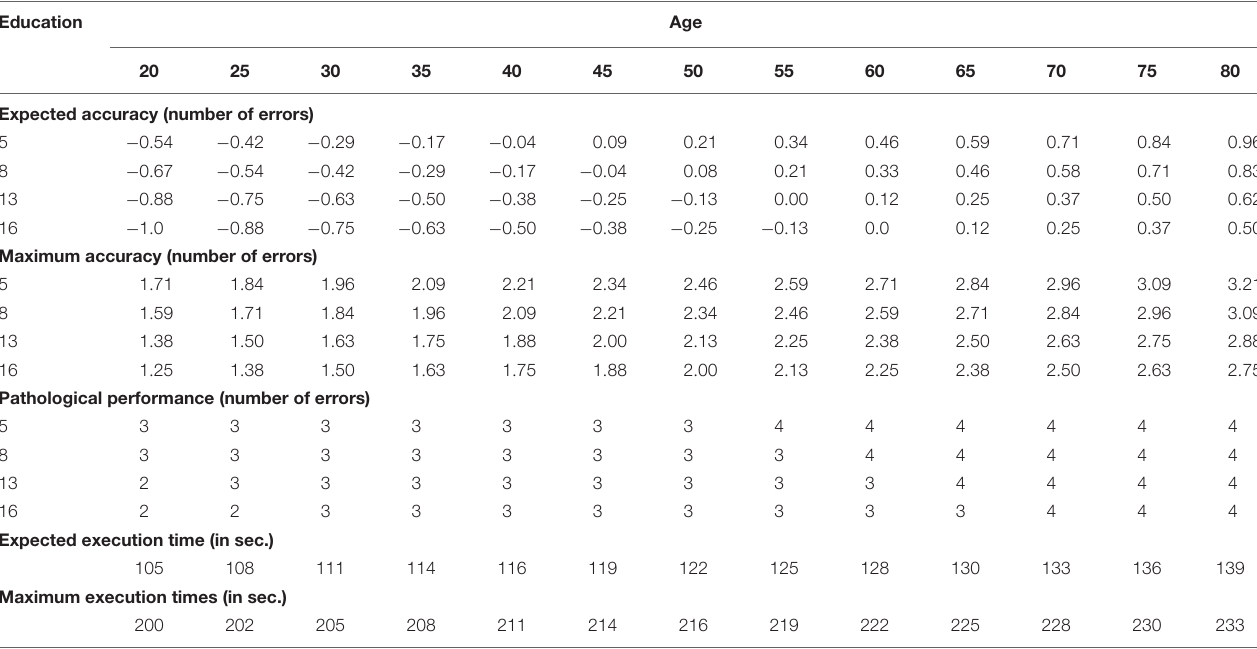
TABLE 2 | Expected accuracy and maximum accuracy (expressed as number of errors) according to age and education. Education